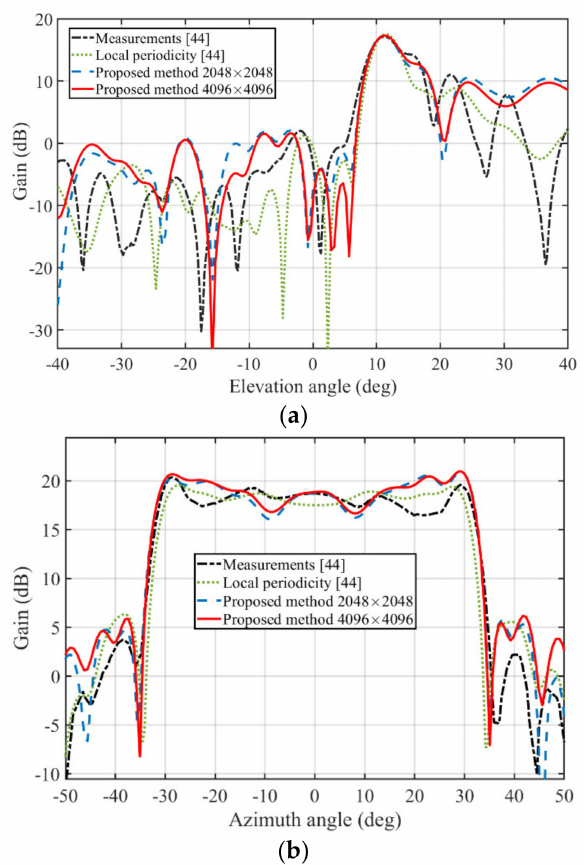
Figure 7. Radiation patterns in elevation plane ( a ) and azimuth plane ( b ) for a shaped beam reflectarray antenna based on elements with three parallel dipoles at 10.4 GHz designed in [44]. The numerical results obtained with the proposed method for 4096 × 4096 and 2048 × 2048 equi-spaced mesh are compared with local periodicity approach and measurements shown in [44].